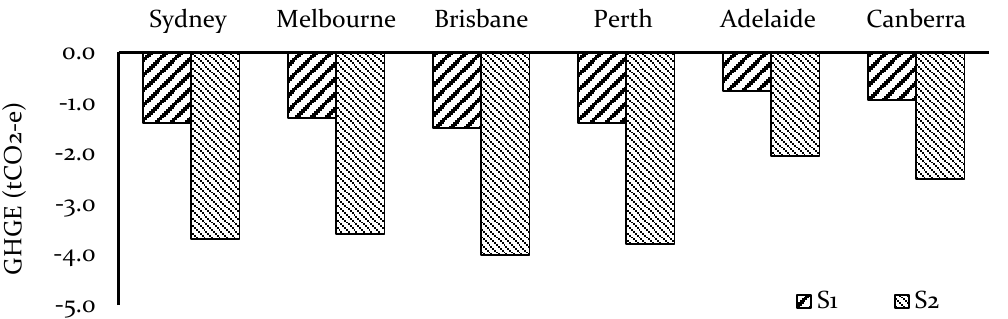
Figure 1. Increases in the GHGE of residential buildings per year when an employee adopts WFH.